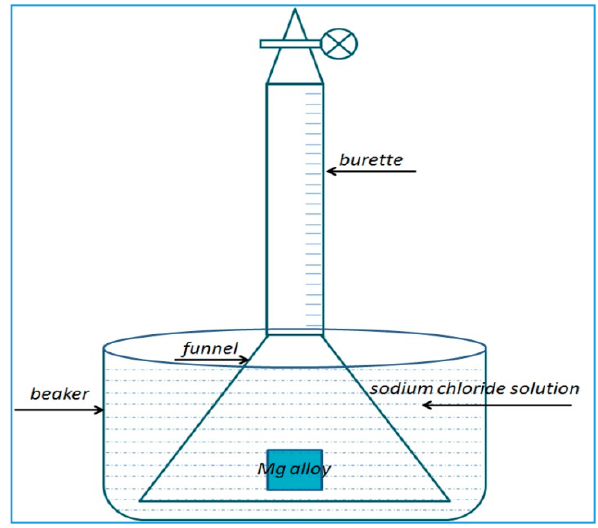
Figure 1. Schematic of the gas collection of magnesium alloys in NaCl solution.